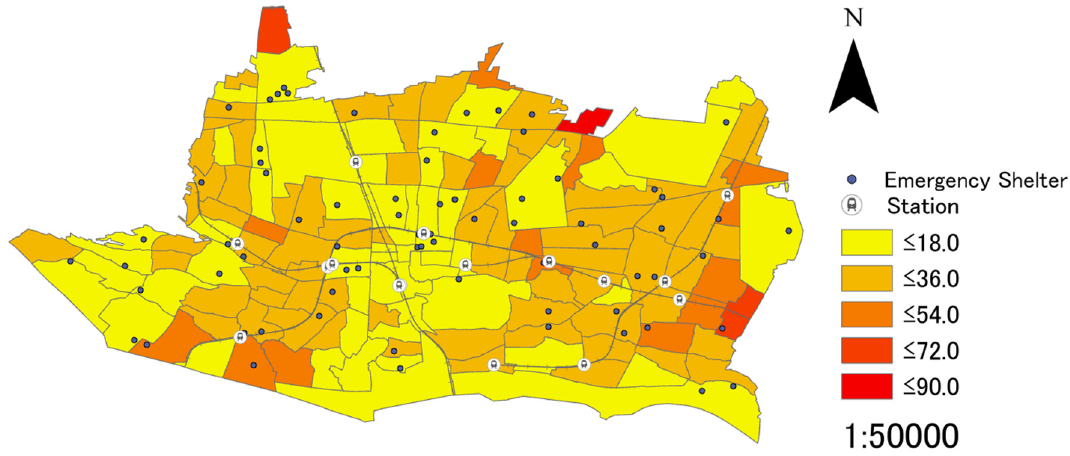
Figure 10. Result for Fuchu City with the specialization coe ffi cient of population density as a